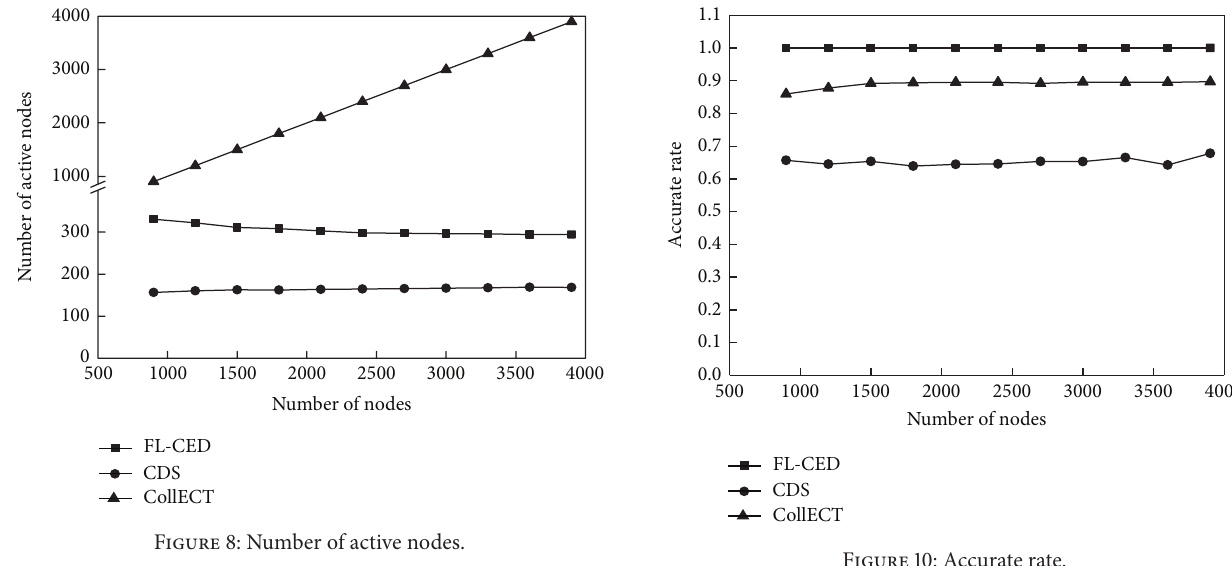
Figure 10: Accurate rate.